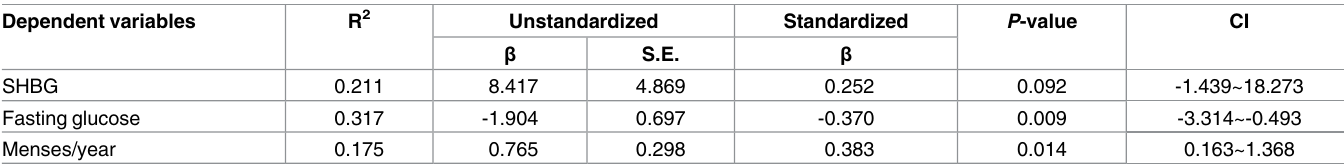
Table 4. Multiple linear regression analysis of relative expression of miRNA-6767-5p with reproductive and metabolic variables. Dependent variables